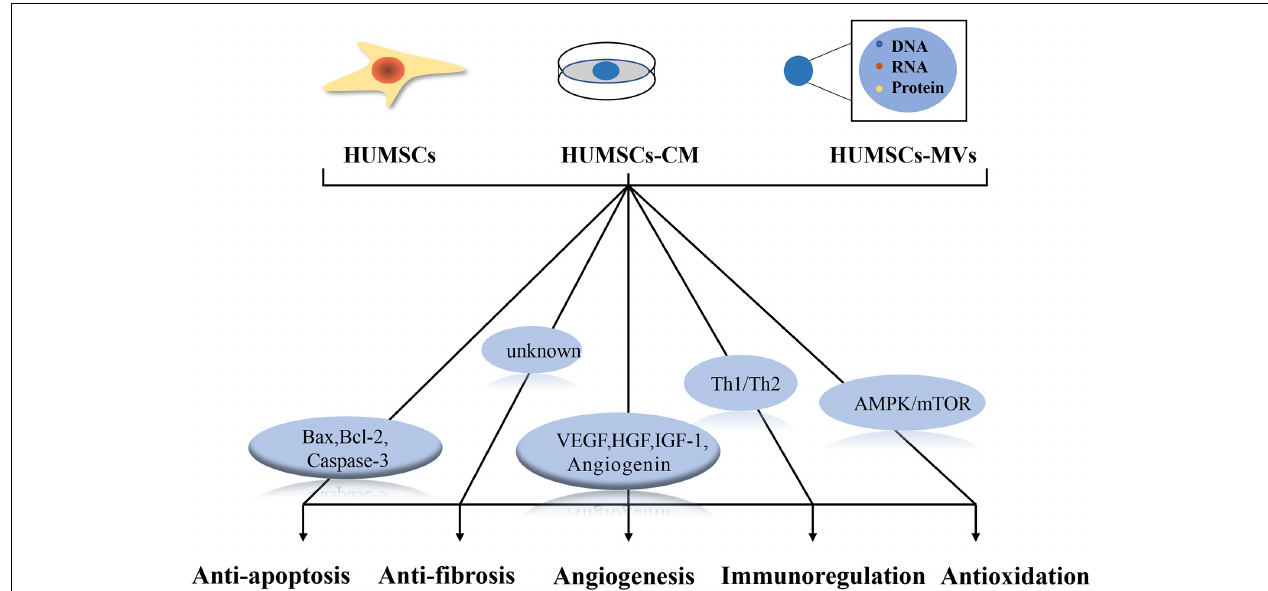
FIGURE 3 | Possible mechanisms underlying the paracrine effect of human umbilical cord mesenchymal stem cells (HUMSCs). HUMSCs, HUMSCs-CM and HUMSCs-MVs all ameliorate ovarian senescence through paracrine effects. Regulation of Bax, Bcl-2, caspase-3 helps to inhibit apoptosis; VEGF, HGF, IGF-1 and angiopoietin play important roles in angiogenesis; Th1/Th2 cytokines play important roles in balanced local immune response; AMPK/mTOR signaling pathway plays an important role in antioxidant process. The mechanism of antifibrosis is not